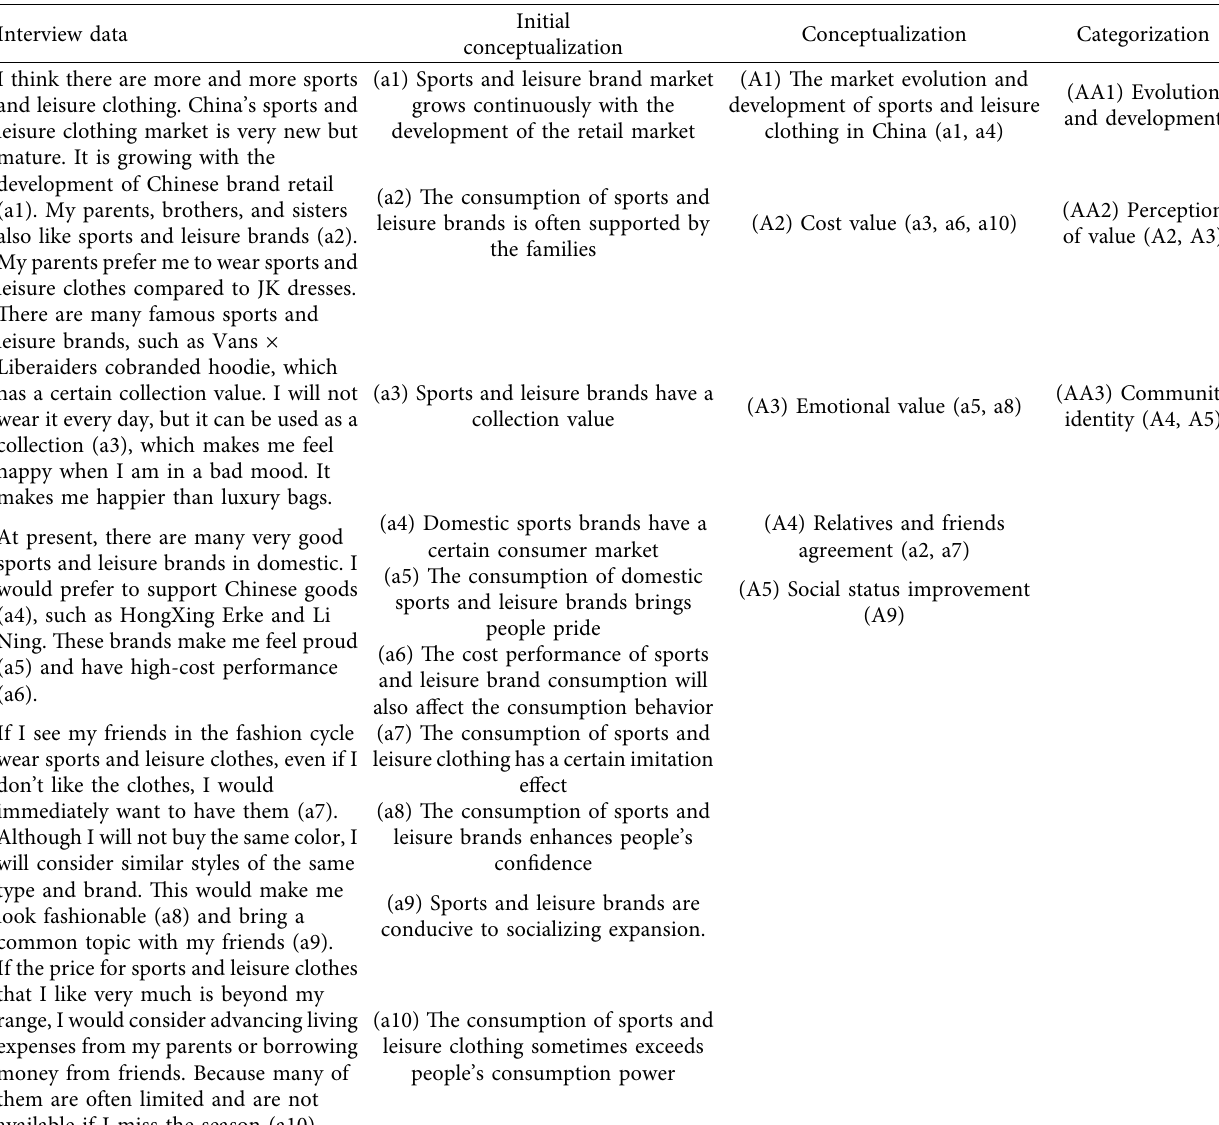
Table 2: Examples of conceptualization and categorization of open